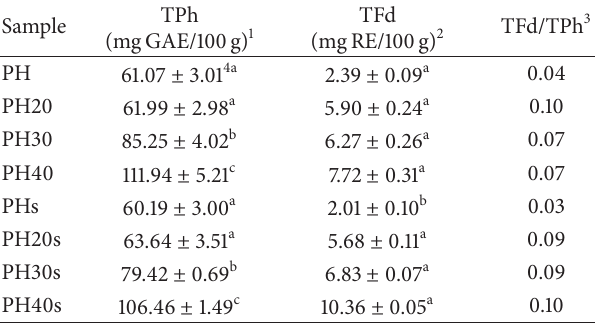
Table 1: Polyphenolic composition of honey samples.